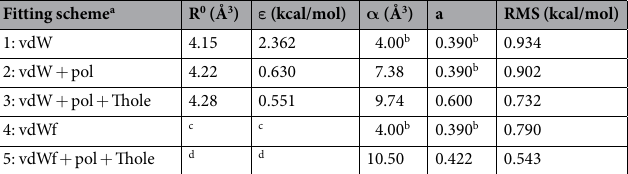
Table 2. Parameters resulting from the different fitting schemes of the Xe–H 2 O potential, along with the RMS error for each fit. R 0 , ε , α , and a are the AMOEBA force field parameters for the xenon atom as described in the Supplementary Information. a Fitted parameters, as described in Section S1.2 in the Supplementary Information; vdW = AMOEBA van der Waals potential, vdWf = modified van der Waals potential, pol = polarizability, Thole = the Thole charge distribution parameter. b Values fixed to the defaults mentioned in Section S1.2 in the Supplementary Information. c The coefficients used in the van der Waals function can be found in Table S1 in the Supplementary Information. d The coefficients used in the van der Waals function can be found in Table S2 in the Supplementary Information.